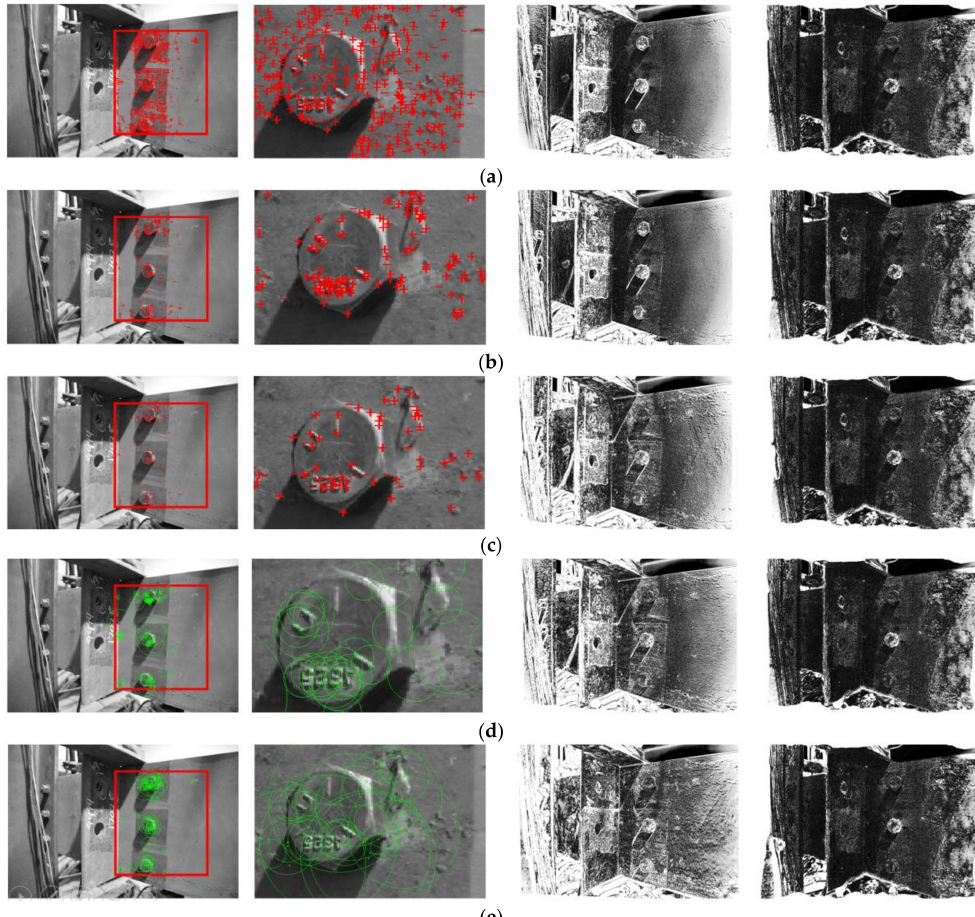
Figure 13. Comparison of bolt loosening detection results with different types of features including ( a ) Shi–Tomasi; ( b ) features from accelerated segment test (FAST); ( c ) Harris–Stephens; ( d ) binary robust invariant scalable keypoints (BRISK); and ( e ) speeded up robust features (SURF). Four columns of Figure 13 represent (1) features in the ROI; (2) detailed look of features around the top bolt; (3) errors after feature-based image registration; and (4) errors after intensity-based image registration. The brightness of the images in the third and fourth columns is enhanced for demonstration